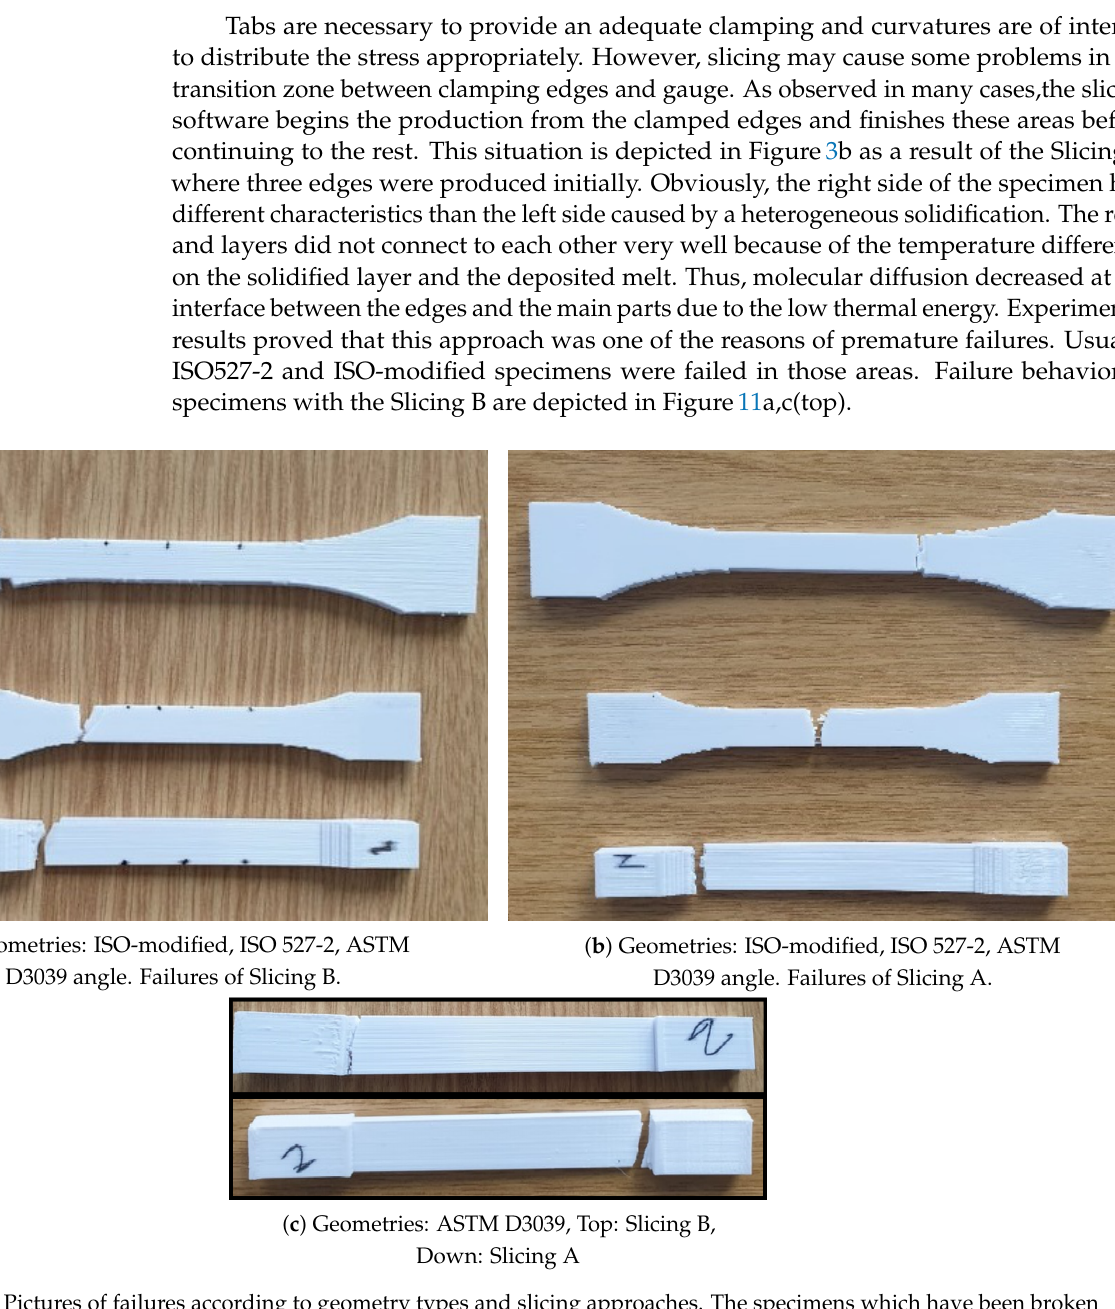
Figure 11. Pictures of failures according to geometry types and slicing approaches. The specimens which have been broken off out of the extensometer limit are provided only for visual observations. Their results are not